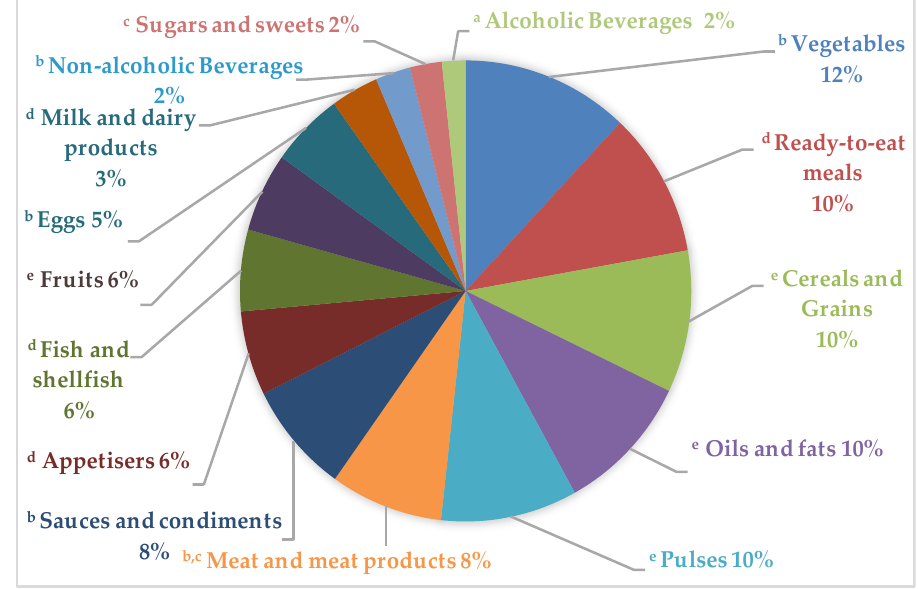
Figure 5. Distribution of food and beverage groups contributing to plate waste generated by the ANIBES study population. Different superscript letters indicate statistically significant differences among groups ( p < 0.05, Student–Newman–Keuls test). Vegetables represented the major food group wasted amongst adolescents (5.2%) and adults (2.6%) (Figure 6), while children discarded a higher proportion of pulses or legumes (5.6%) and the elderly left meat and meat products (1.1%). Furthermore, household and out-of-home PW was highest amongst children across all food groups, except for fish and shellfish, which was higher in adolescents, followed by children and adults. Finally, it can be observed that the elderly was the age group who generated the lowest PW across all food categories.